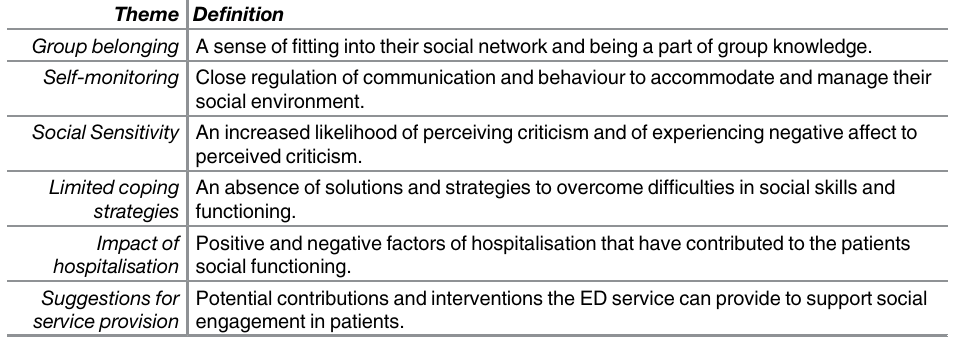
Table 3. Themes identified from the focus groups and interviews. Group belonging A sense of fi tting into their social network and being a part of group knowledge. Self-monitoring Close regulation of communication and behaviour to accommodate and manage their social environment. Social Sensitivity An increased likelihood of perceiving criticism and of experiencing negative affect to perceived criticism.